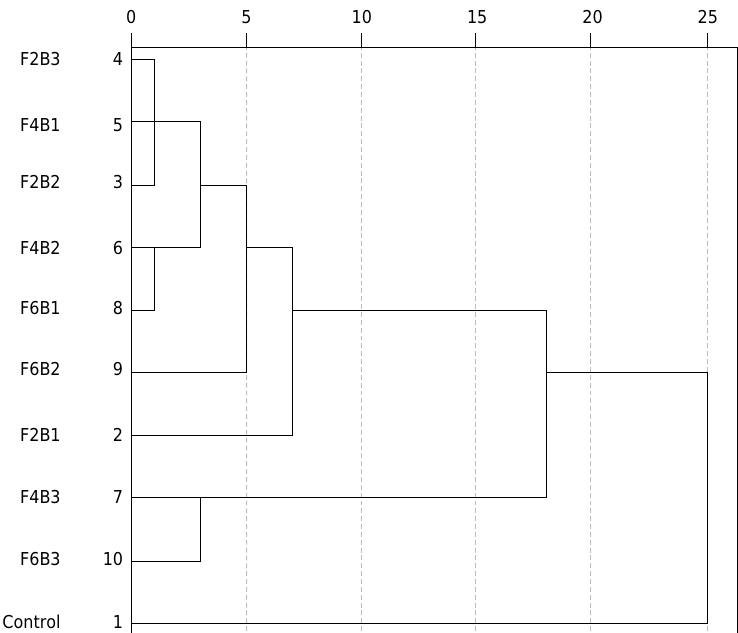
Figure 2. Cluster analysis of soil properties and corn growth under different